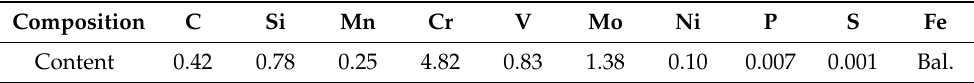
Table 1. Chemical compositions of as-received H13 hot-work tool steel (wt%).